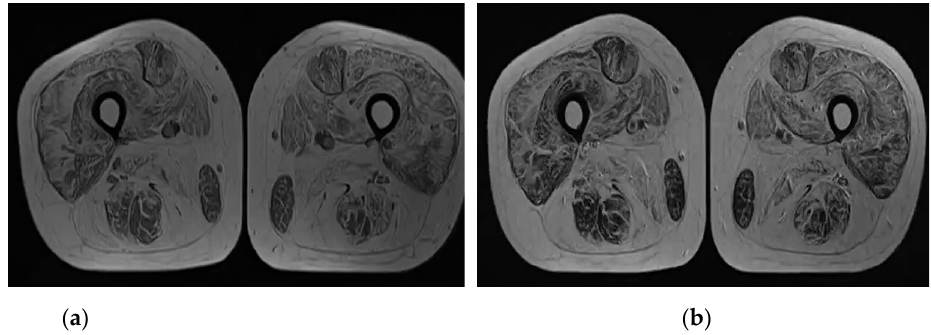
Figure 2. ( a ) Axial T1-weighted MRI scan with diffuse increase of signal intensity from all muscles of the both shins; ( b ) Axial T2 weighted MRI scan with diffuse increase of signal intensity from all muscles of the both shins.